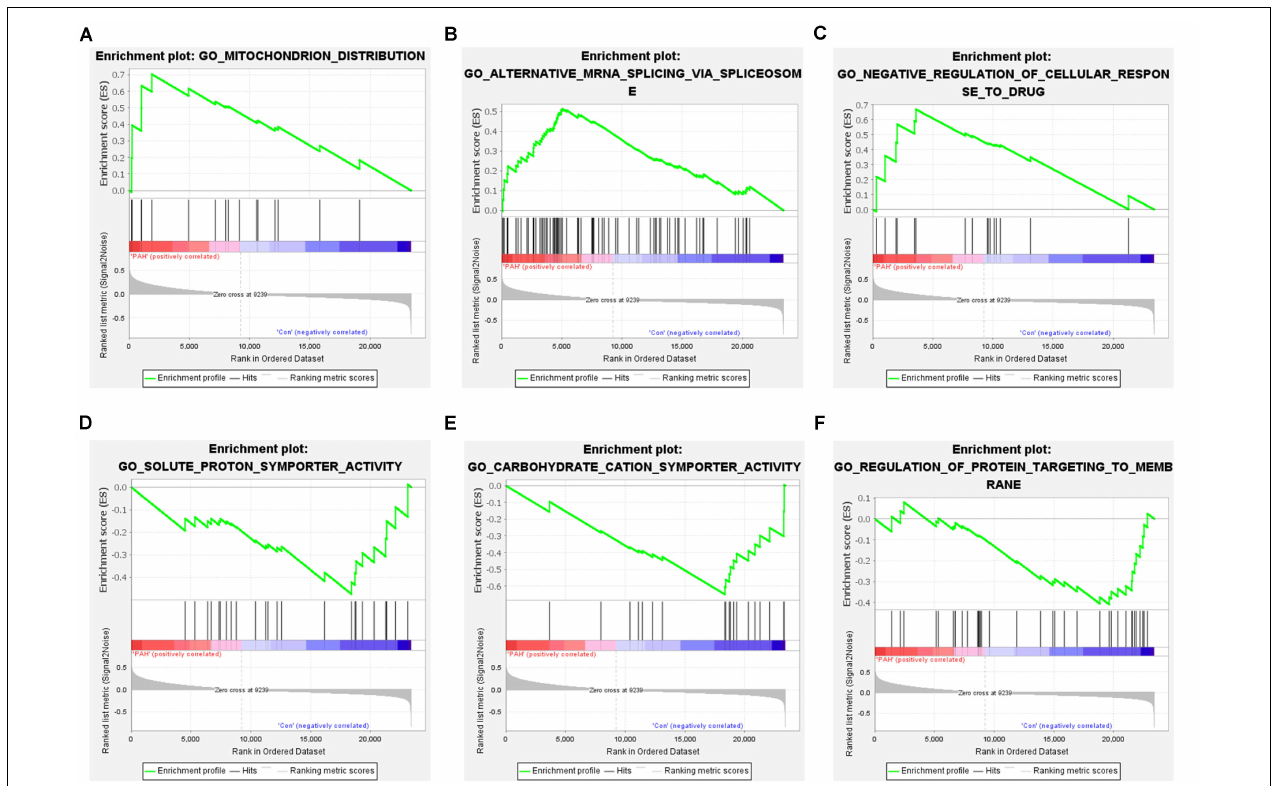
FIGURE 3 | Gene set enrichment analysis of all genes. (A–C) Enrichment results of up-regulated genes. The GO terms enriched in PAH tissues included mitochondria distribution, alternative mRNA splicing via spliceosomes, and negative regulation of cellular responses to drugs. (D–F) Enrichment results of down-regulated genes. Solute proton symporter activity, carbohydrate cation symporter activity, and regulation of protein targeting to the membrane were mainly enriched in healthy lung tissues.